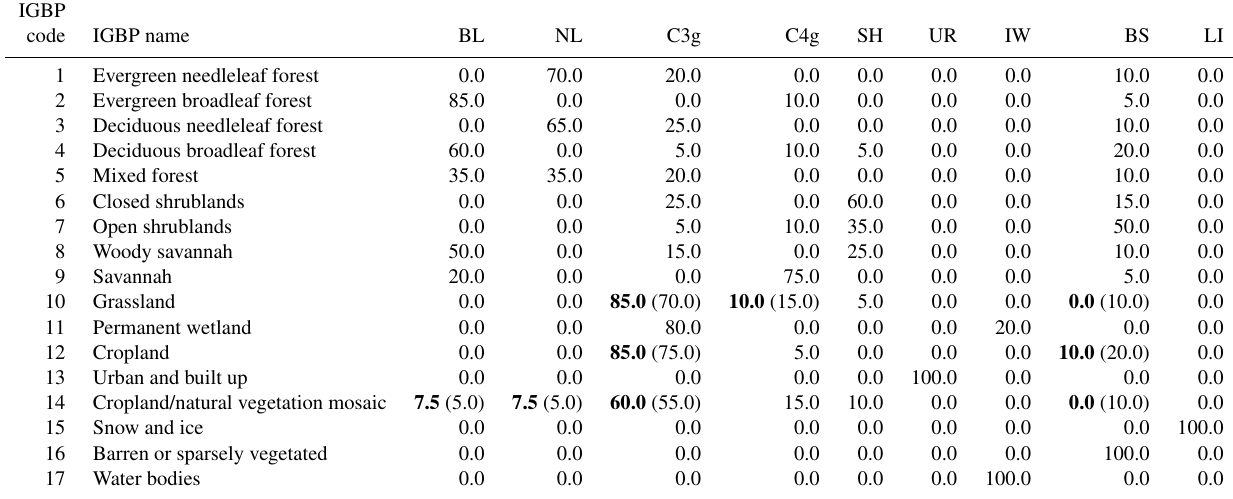
Table 5. Mapping from IGBP classification to JULES land surface types in GL7 (%). The abbreviated headers are broadleaf trees, needle- leaved trees, temperate C 3 grass, tropical C 4 grass, shrubs, urban areas, inland water, bare soil and land ice surface types respectively. Values that have changed are marked in bold with GL6 values in